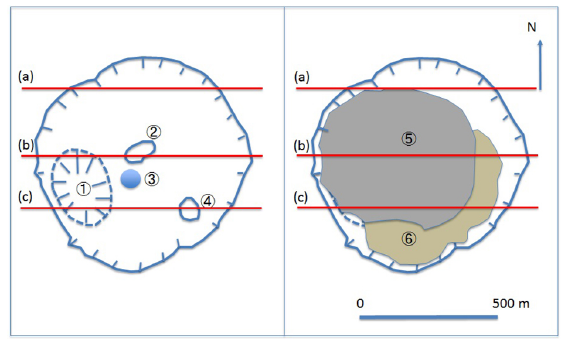
Figure 18. Schematic of the Shinmoe-dake caldera after the 2011 eruption (Nakada et al., 2013). The left and right panels, respec- tively, show the caldera immediately after the eruption (28 January 2011) and after more than a year had passed (the summer of 2012). The numbers in the plot indicate the following: 1, a vent of sub- plinian events; 2, a vent of continuous emission of fine ash; 3, a lava dome; 4, a steam vent; 5, the limit of lava accumulation; and 6, al- tered, thickly deposited ash. The vertical cross sections are plotted along three red horizontal lines ( a , b , and c ) in Fig. 19.